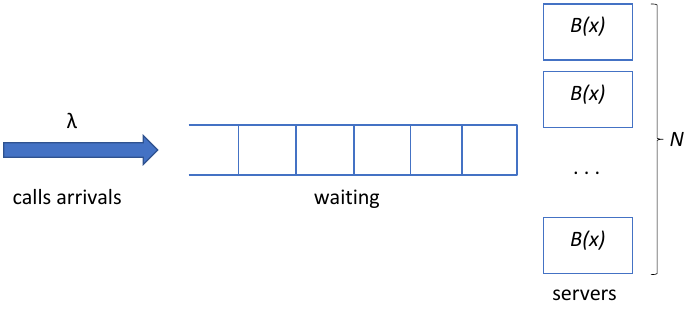
Figure 1. Structure of the